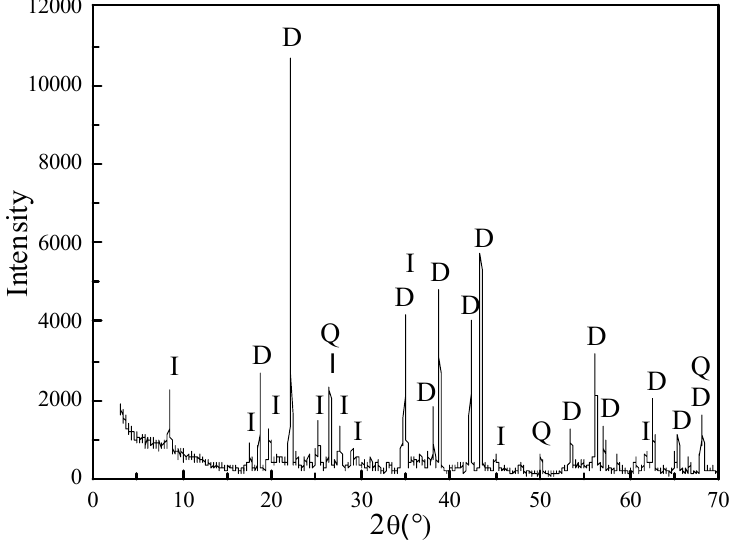
Figure 2. X-ray diffraction (XRD) pattern of the bauxite sample (D, diaspore; Q, quartz; I, illite).